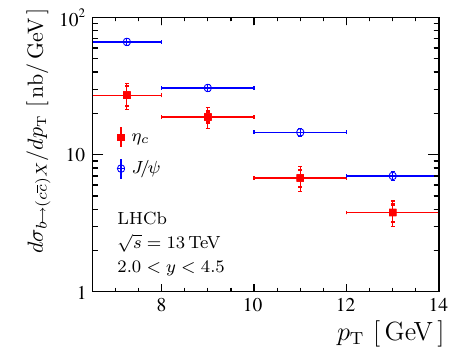
Fig. 4 Differentialproductioncross-sectionsof η c (redrectangles)and J /ψ (blue circles) for (left) prompt production and (right) production in b -hadron inclusive decays. The uncertainties for η c production are sta- tistical, systematic, and due to the η c → pp and J /ψ → pp branching